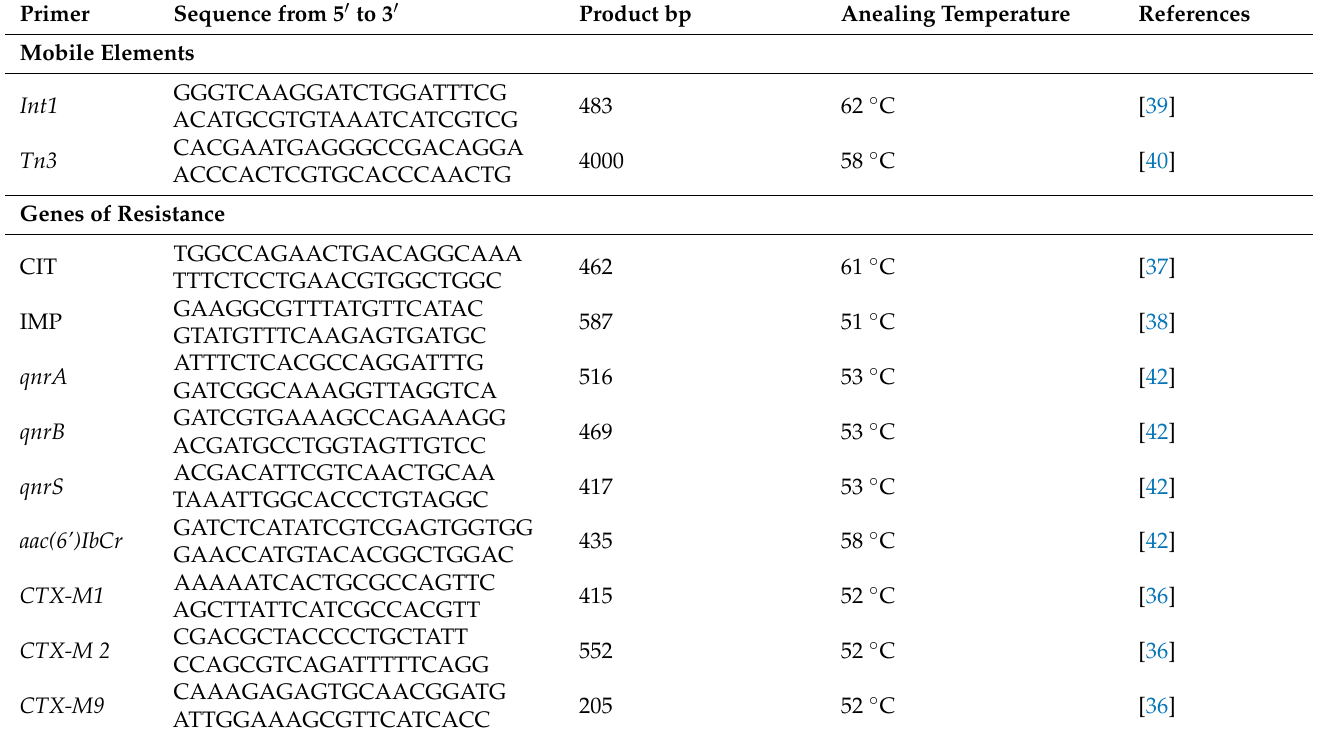
Table 2. Used primers and PCR conditions for the detection of resistance genes and mobile elements. Primer Sequence from 5 (cid:48) to 3 (cid:48) Product bp Anealing